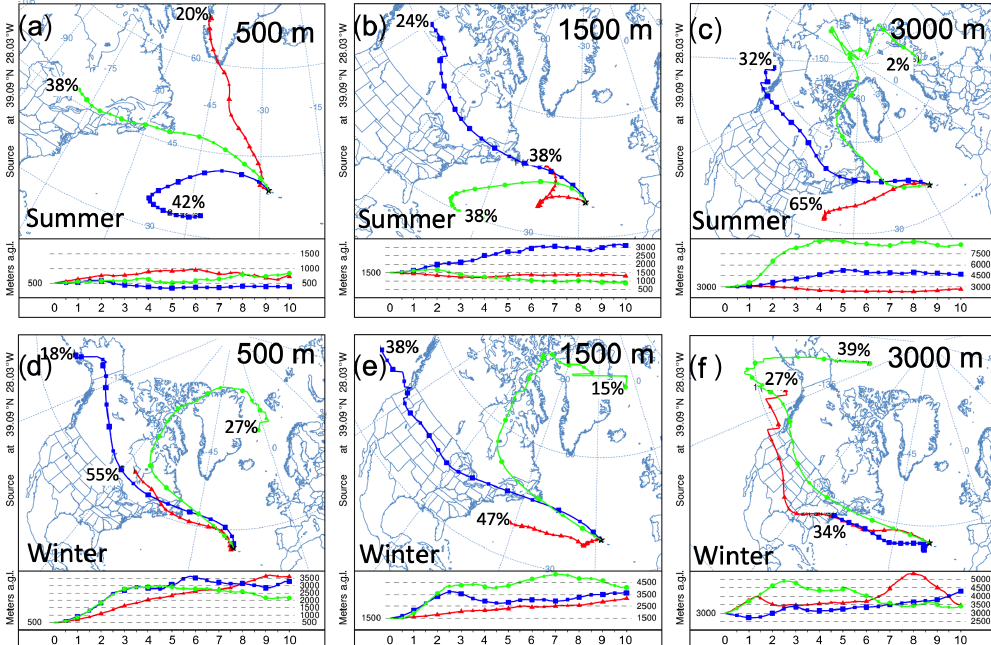
Figure 3. Cluster analysis of 10d back trajectories arriving at 500, 1500, and 3000m above the ENA site during the summer (a) – (c) and winter (d) – (f) IOP. The average 10d back trajectories of the three clusters are represented by red, green, and blue lines, and the associated numbers denote the occurrence percentages of the clusters.